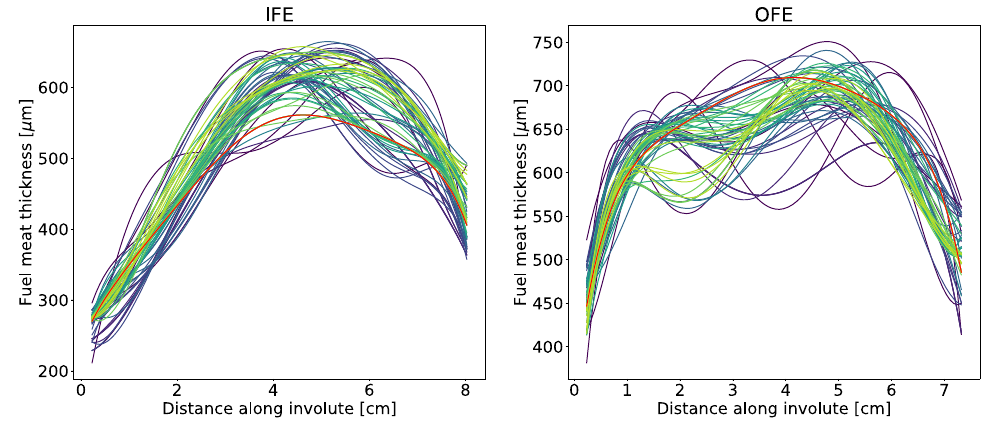
FIGURE 5. Evolution of fuel shape with each generation. Lighter colors denote higher generations. The shape converges to a smaller variance with successive generations. The red line is the final shape that does not have a point of